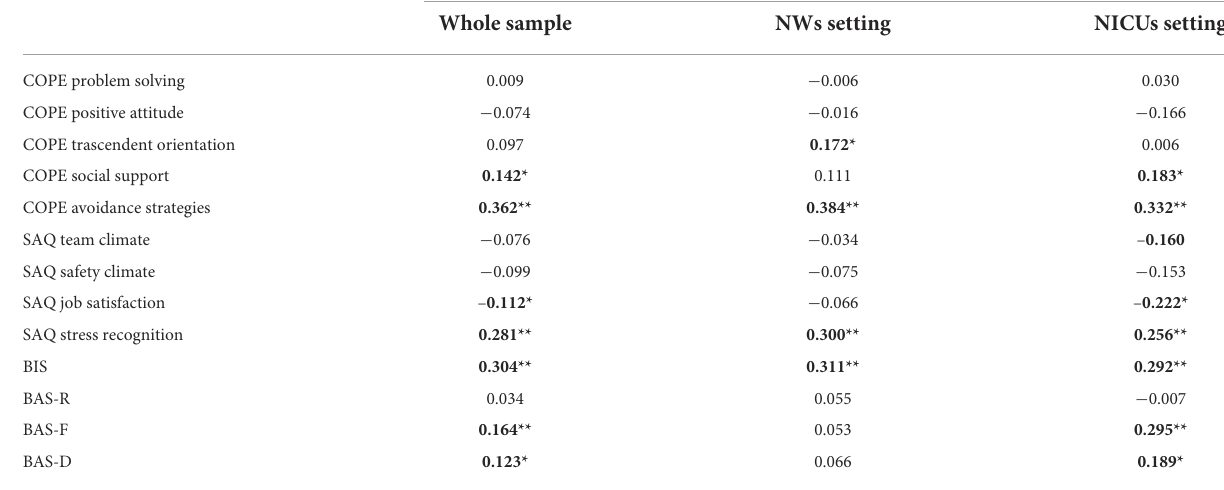
TABLE 2 Bivariate correlations among study variables and emotional distress index.